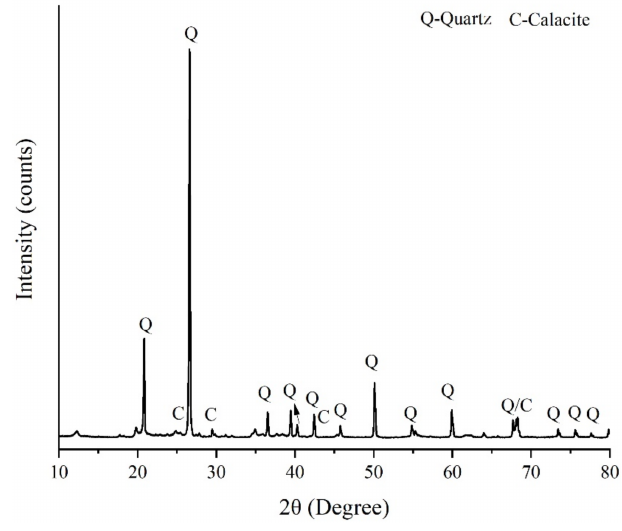
Figure 4. X-ray diffraction patterns of dredged sludge.